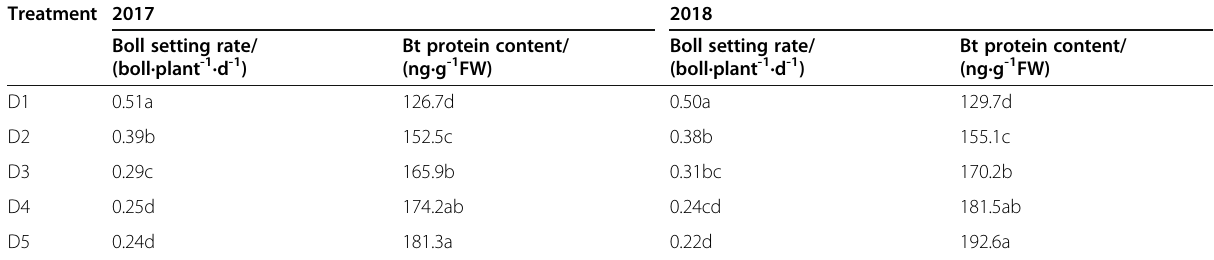
Table 1 Effect of plant density on boll setting rate and Bt toxin content in boll wall in 2017 and 2018 Treatment